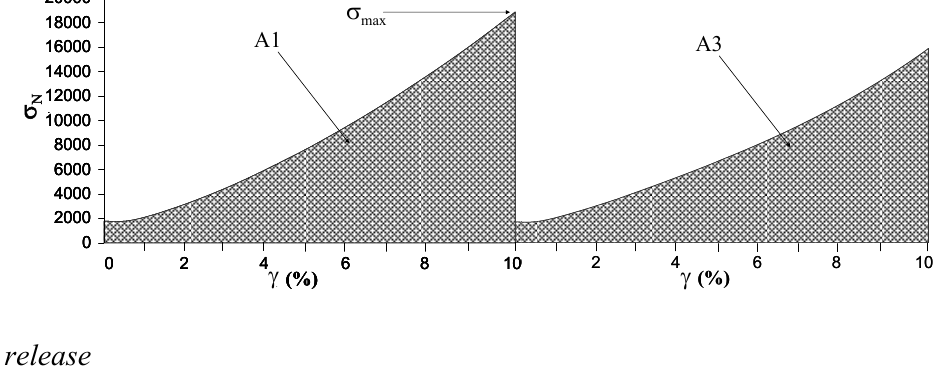
Figure 9. Stress-Deformation curves for the 1 st and 3 rd compression.  max =  N (  = 10%), A1, A3 = areas under the stress-deformation curves (  =